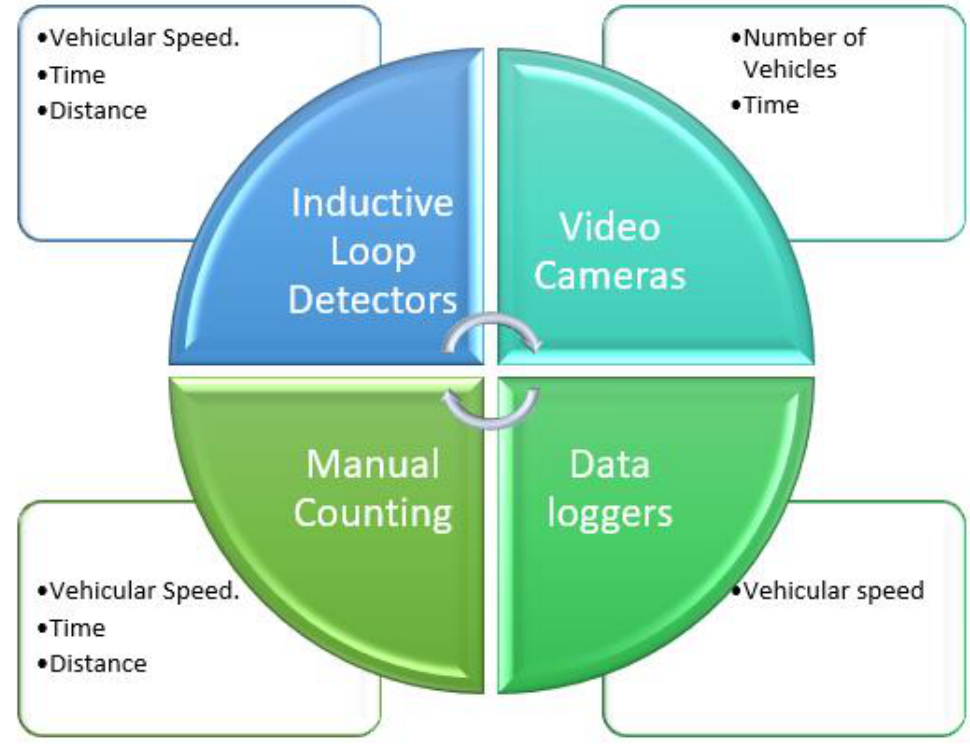
Figure 2. Collection of traffic datasets.